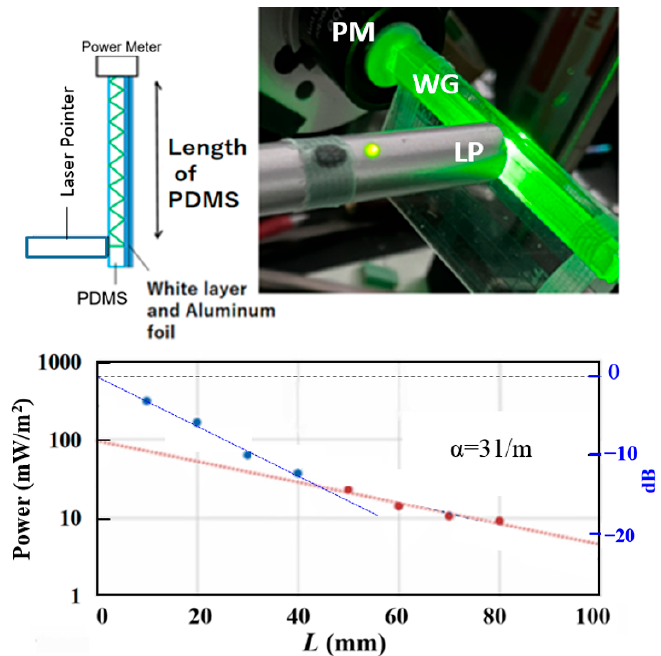
Figure 4. The power of guided light is plotted as a function of the distance between the green laser pointer (PD) and the power meter (PM) for the planar PDMS waveguide (WG), one side of which is covered with a white paper followed by aluminum foil (RSC WG). The red line was obtained from red solid circles excluding the data (blue solid circles) for positions near the edge at which the power meter is placed, and the blue line was fitted to the blue solid circles to extrapolate the value at L = 0. The right ordinates show the power loss in dB. The top left inset depicts the configuration of the experiment, a picture of which is shown in the right top inset; LP is the laser pointer, PM is the power monitor, and WG is the RSC